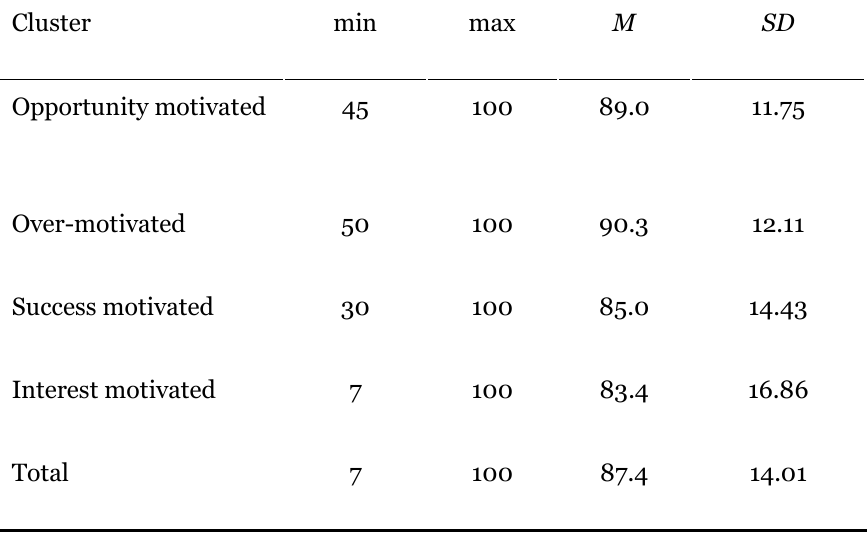
Self-Evaluated Probability of Completing the MOOC in Percentages by Clusters Cluster Opportunity